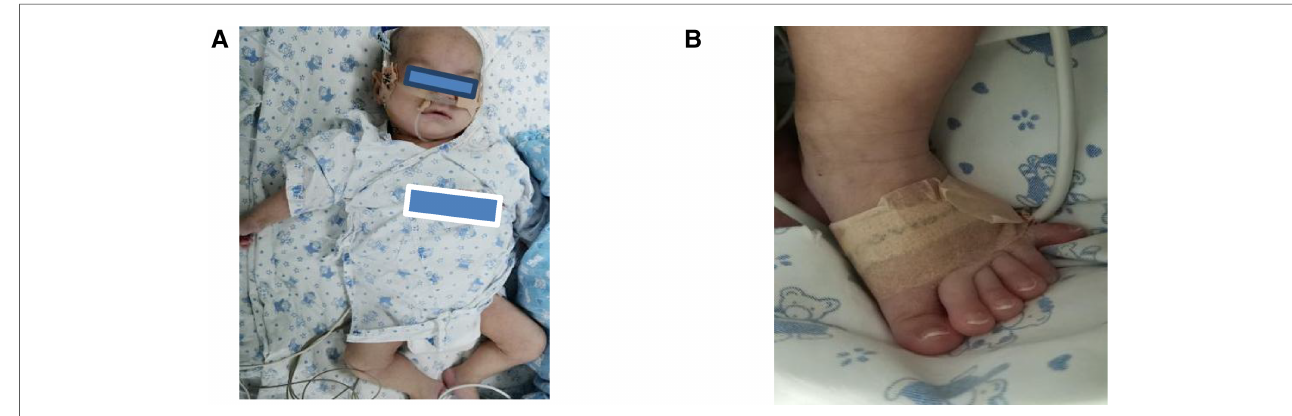
FIGURE 1 (A) A reticular erythematous path across the body, arched eyebrows, down-slanting palpebral fi ssures, a broad nasal bridge, and a triangular mouth. (B) The patient had polydactyly and broad big